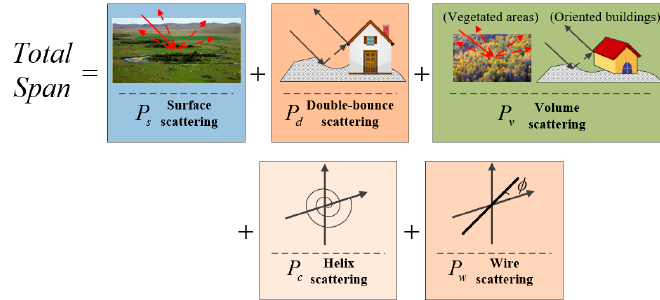
Figure 1. Improved multiple-component model-based decomposition framework.